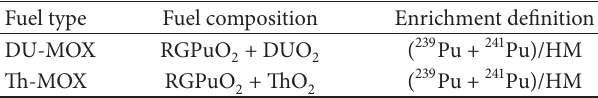
Table 3: The different fuel forms chosen for study.